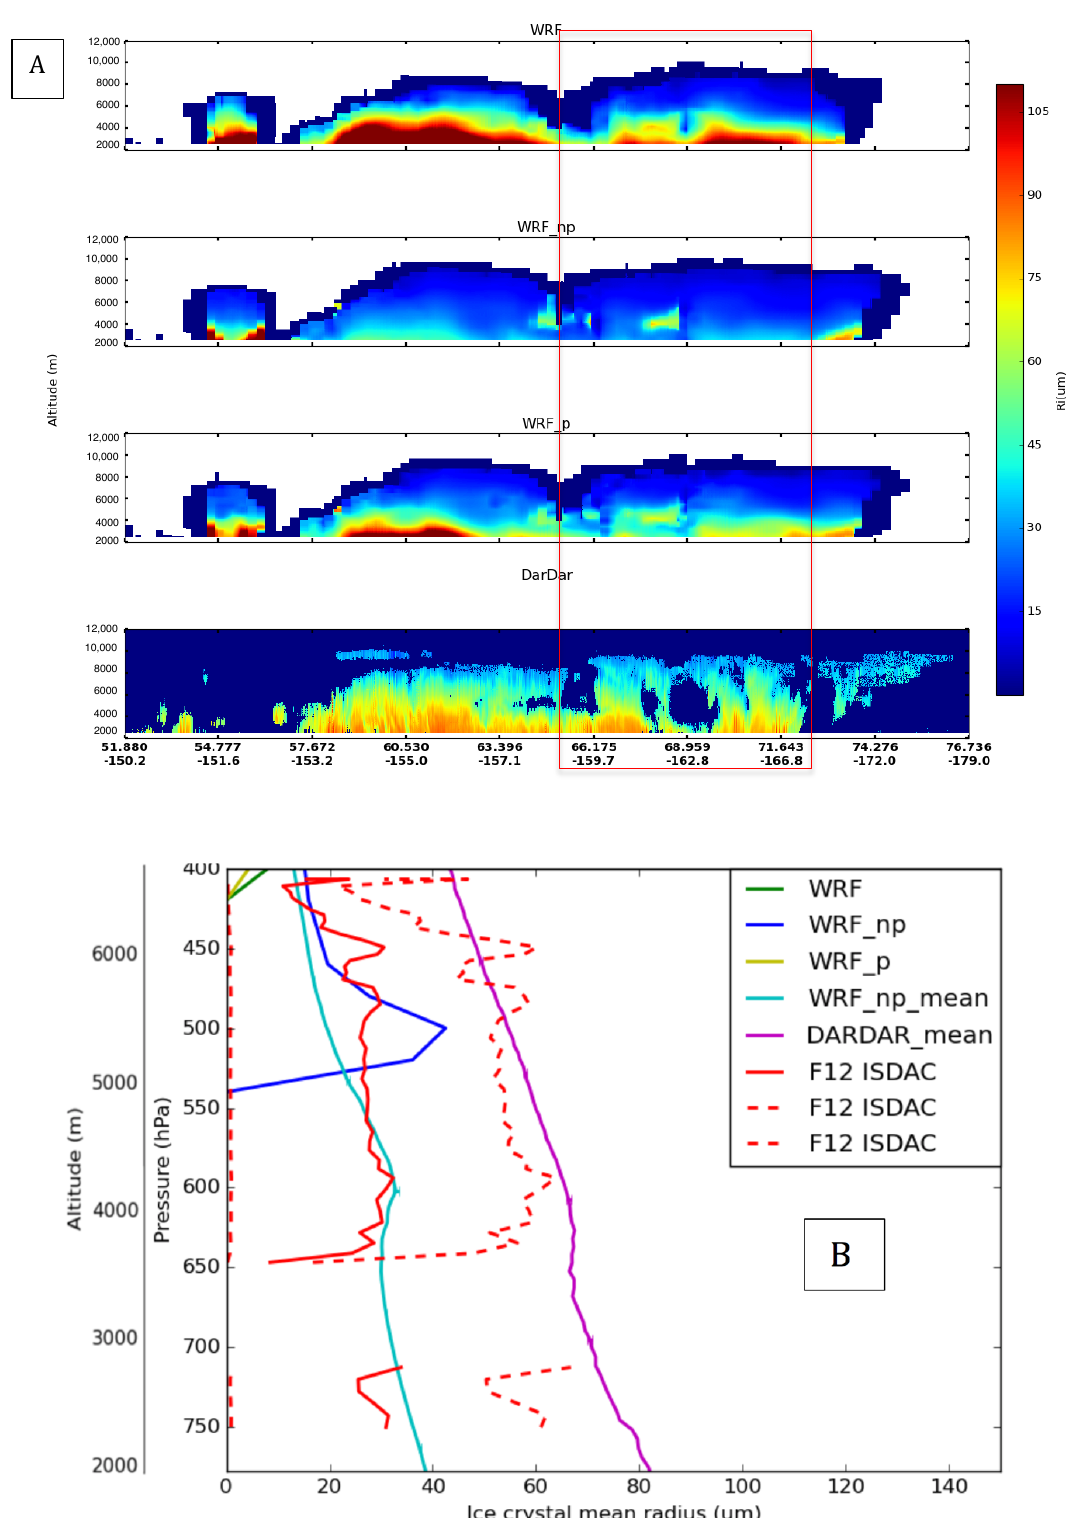
Figure 10. Observed and simulated (WRF, WRF_np and WRF_p) Ri along T12 track ( A ) and F12 flight ( B ). Simulated profile WRF_np_mean averaged along the satellite track over the larger domain of Figure 1 is also shown on ( B ) together with DARDAR-retrieved average profile. The dashed red line on ( B ) represents the variability (standard deviation) of ISDAC